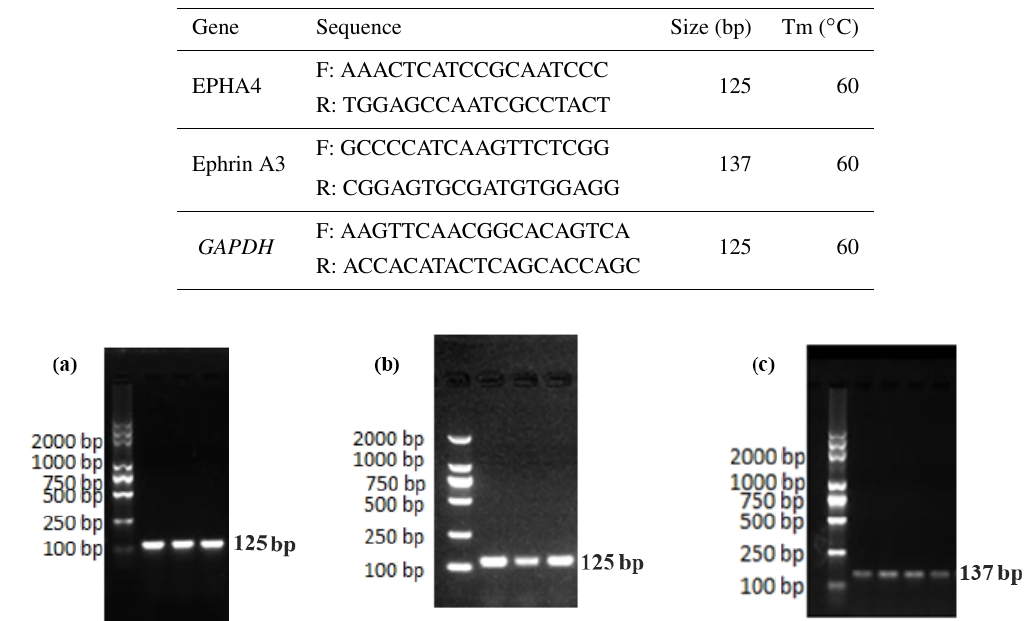
Table 1. Primers sequences for EPHA4, Ephrin A3, and GAPDH genes.